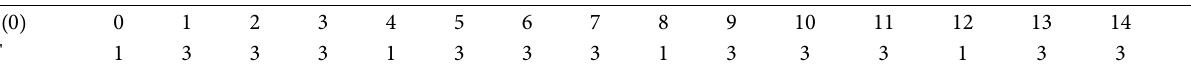
Figure 2: Time series of digitized logistic map when Table 1: Initial values and cycle